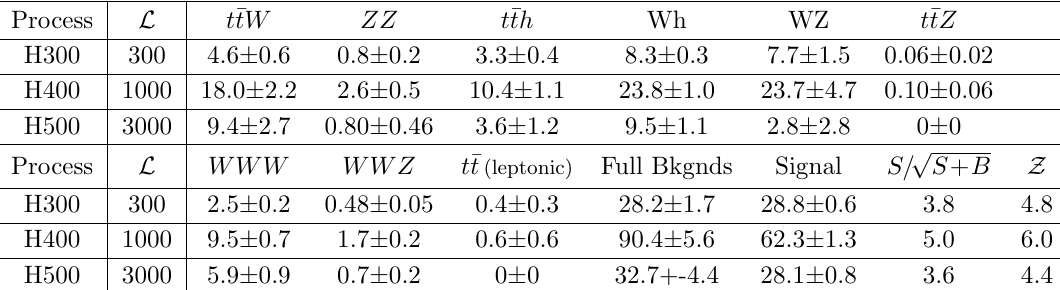
Table 7 . BDT optimization in the tri-lepton (3L) channel for the three benchmarks with di(cid:11)erent integrated luminosity L (in the unit of fb (cid:0) 1 ). We present, after the optimal BDT cuts, the selected event numbers for the signals and backgrounds (in which the Z +jets background is negligible and not listed here), as well as the median signi(cid:12)cance Z